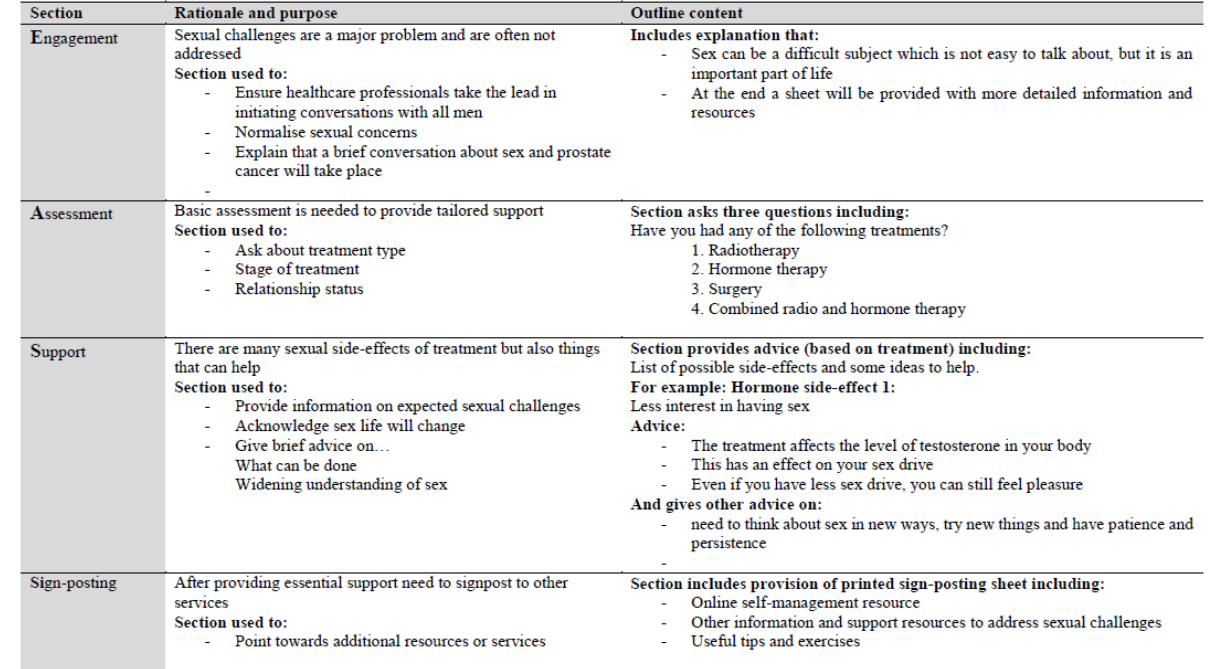
Figure 1. Purpose and outline content of the Engagement, Assessment, Support, and Sign-Posting (EASSi)